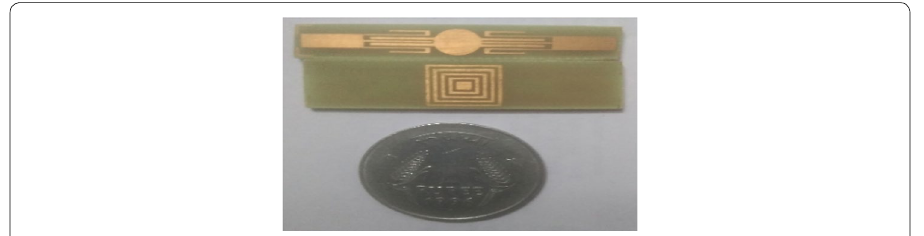
Fig. 8 Group delay response of DB-BPF